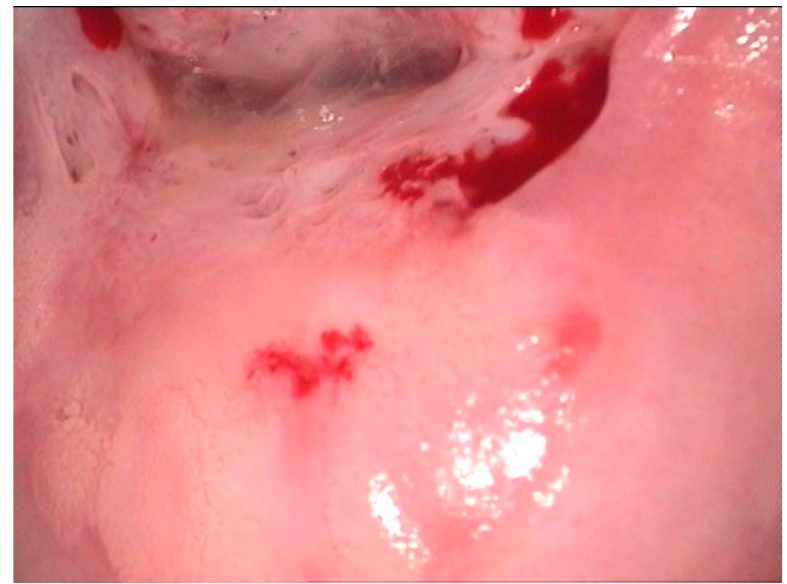
Figure 10. Colposcopic image of high-grade lesion revealed by coarse aceto-white epithelium on the posterior lip depicting mosaic, petechial junctional zone, and glandular criptae.